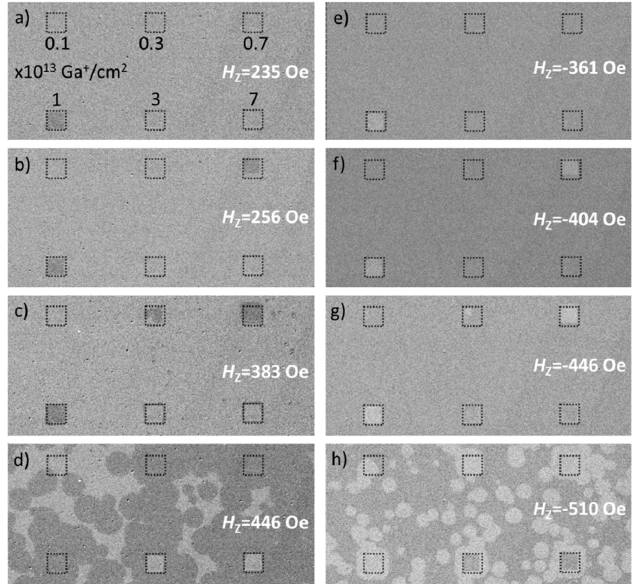
Figure 1. Differential polar magneto-optical Kerr effect (P-MOKE) images of the domain structure recorded in remanence for non-bombarded areas and for areas bombarded with different fluency F (dotted squares), taken after different H z pulses ( a – h ). Prior to the measurements, the Ti 4 nm/Au 60 nm/Co 0.6 nm/NiO 10 nm sample was saturated at H z = − 2100 Oe ( a – d ) and at H z = +2100 Oe ( e – h